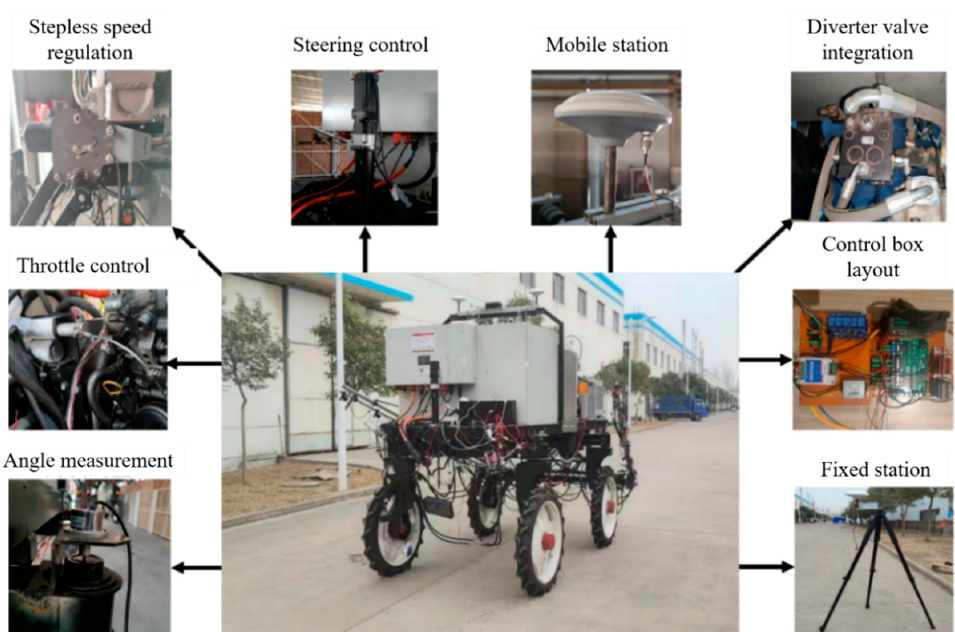
Figure 17. 4WS autonomous navigation agricultural machinery test platform.